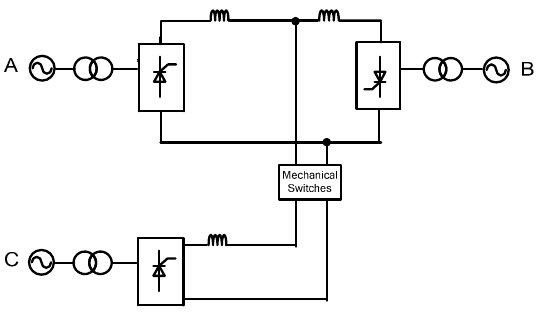
Figure 1. Configuration of the line ‐ commutated converter based multi ‐ terminal HVDC (LCC ‐ MTDC).